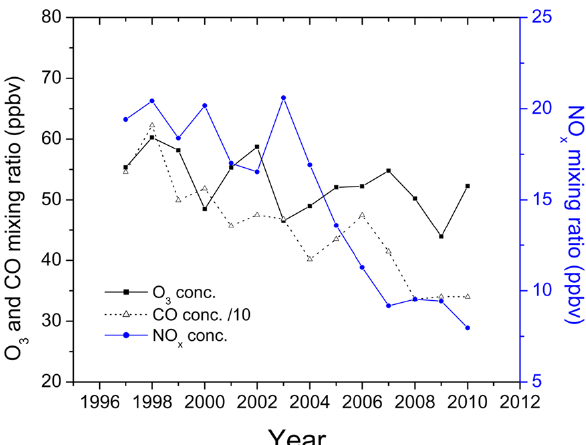
Fig. 4. Linear regression analysis of long-term EPA AQS obser- vations of surface ozone in the Baltimore/Washington area. Ozone data are the same as in Fig. 3; and the linear regression of ozone is with respect to